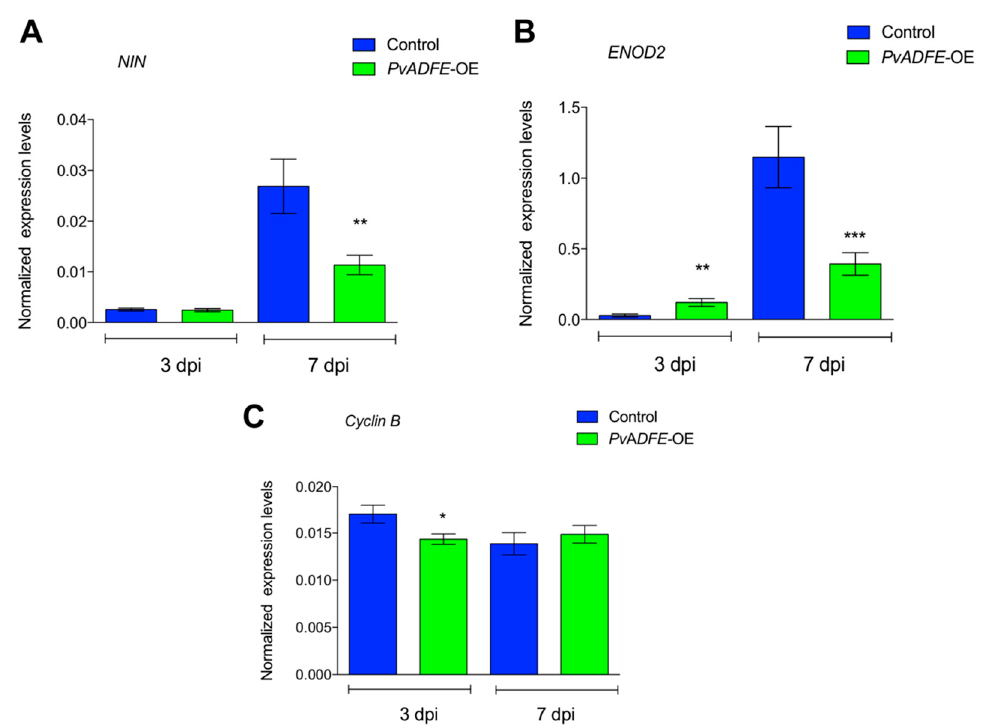
Figure 6. Reverse-transcription quantitative PCR analysis of early nodulins in PvADFE -OE and control transgenic roots after inoculation with R. tropici CIAT-899. ( A ) NIN , ( B ) ENOD2 , and ( C ) Cyclin B transcript accumulation profiles determined by qRT-PCR of total RNA isolated from PvADFE -OE and control transgenic roots at 3 and 7 days after inoculation with rhizobia. Elongation factor EF1 α was used as an endogenous reference gene for normalizing expression levels. Each bar represents mean ± SEM for two independent biological replicates with three technical repeats. * p < 0.05, ** p < 0.005, and *** p < 0.001 according to Student’s t -test.